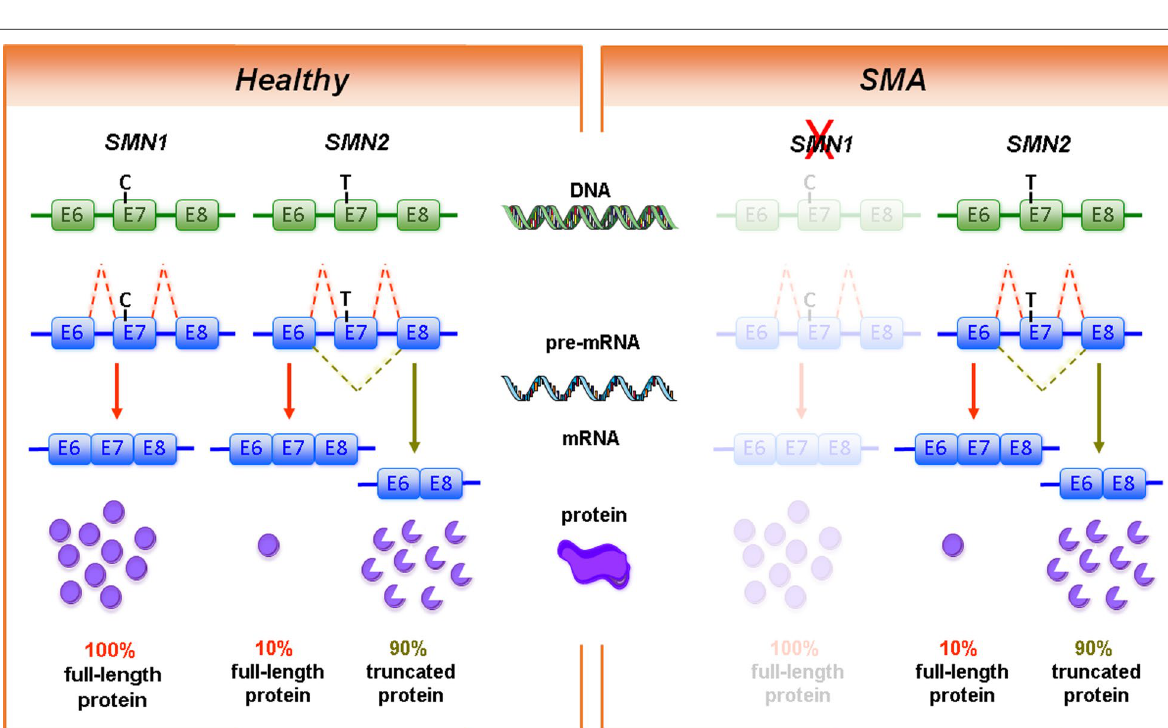
Fig. 1 Genetic cause of spinal muscular atrophy (SMA). The human survival motor neuron genes ( SMN1 and SMN2 ) are located in an inverse duplicated region on chromosome 5q13.2. On DNA level, the two genes only differ by one functionally relevant nucleotide exchange within exon 7. This transition from C to T results in the generation of an exonic splicing silencer (ESS) site leading to exon 7 skipping on mRNA level. While SMN1 codes for the functional, full-length SMN protein, SMN2 predominantly (~ 90%) produces a truncated, non-functional version of the protein. SMA is caused by homozygous deletions of SMN1 resulting in highly reduced SMN protein levels. However, the number of SMN2 copies that determines the amount of functional SMN protein can modify disease